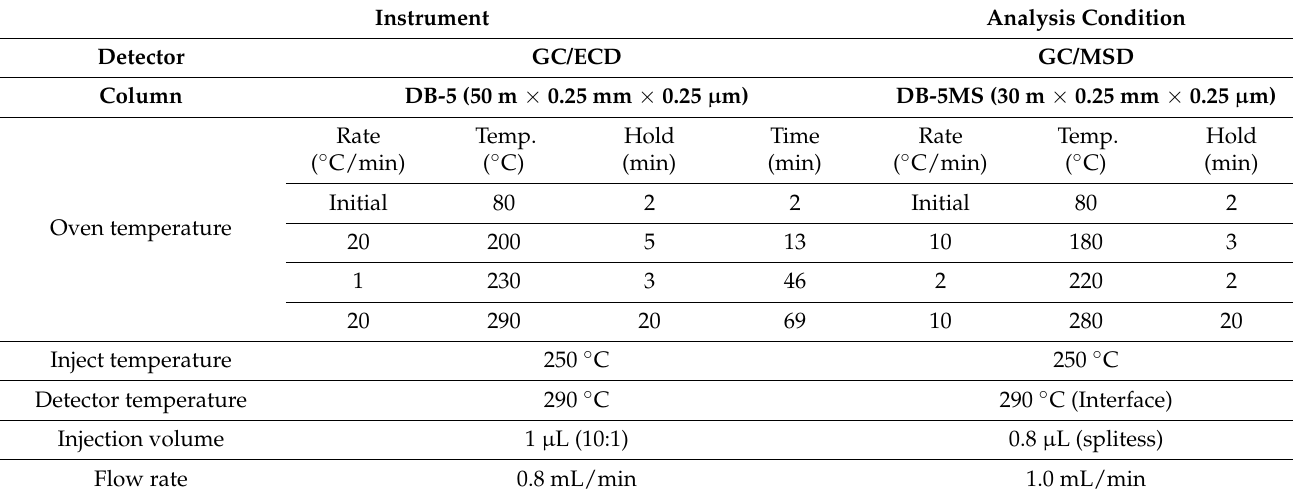
Table 3. Analysis conditions of GC/ECD and